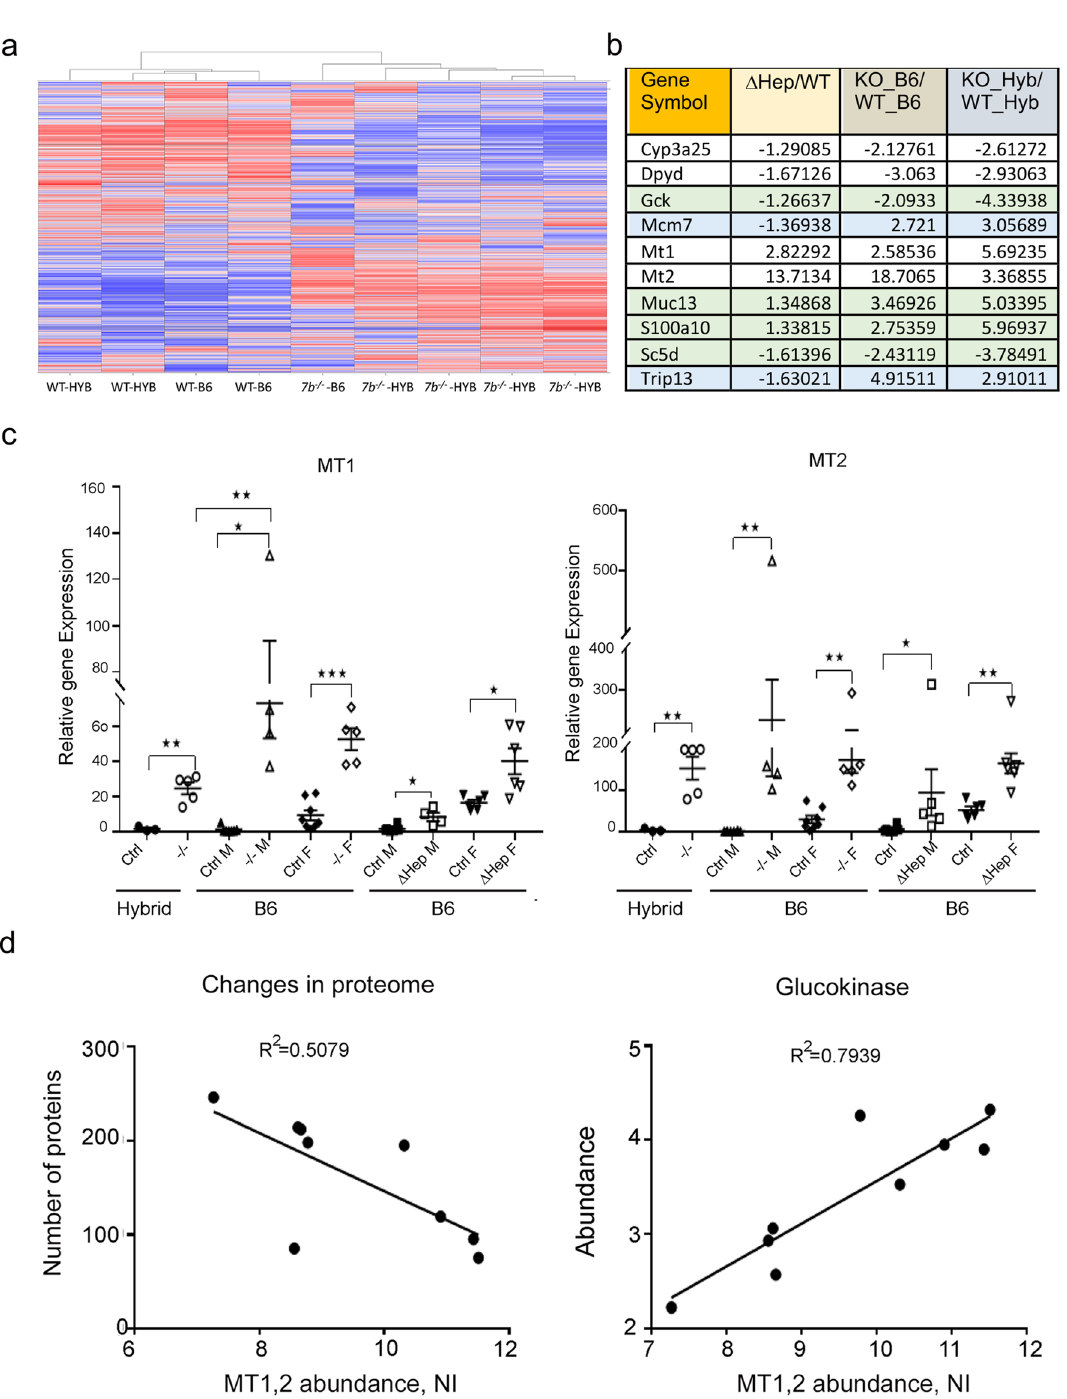
Figure 8. Comparison of Atp7b mutant mice suggests potential markers and modifying factors. ( a ) Unsupervised clustering of protein profiles from the dataset # 2 (see methods) was done using Spotfire DecisionSite with Functional Genomics v9.1.2 (https :// edeli very.tibco .com/store front /eval/tibco -spotfi re-decis ionsi te-for-funct ional -genom ics/prod1 0196.html) and presented as a heat map; the map illustrates marked differences between the wt animals and Atp7b − / − global knockouts and presence of similarly changed proteins in Atp7b − / − mice on different genetic backgrounds heat map ( b ) The most significantly dysregulated proteins (|S|= 6, p value < 0.05) detected in all Atp7b -mutant mice. Green color highlights protein with changes in abundance that reflect the extent of liver pathology; blue indicate proteins that are oppositely changed in the hepatocyte-specific and global knockouts; ( c ) Upregulation of metallothioneins MT1 and MT2 in Atp7b -deficient strains. One-way ANOVA and a two-tail t-test for individual pairs (shown) were used (* p value ≤ 0.05, ** p value ≤ 0.01, *** p value ≤ 0.001) and yielded same conclusions. “Ctrl” indicates either Atp7b + / + or Atp7b + /- animals; “M”—males; “F”—females. ( d ) Left: Correlation between the abundance of metallothioneins MT1 and MT2 in individual Atp7b − / − animals and the number of proteins in their liver proteome changed more than1.5-fold compared to the averaged wild-type on the same genetic background. Right: Correlation between abundances of MT1 and MT2 and levels of glucokinase in individual Atp7b − / − animals. “NI” indicates a normalized protein